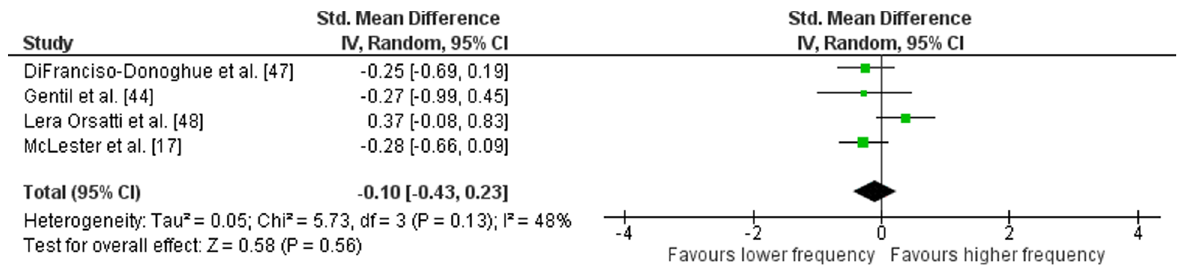
Fig. 14 Lower vs. higher weekly training frequency. Pre- vs. post-mean ES strength difference on isolation exercise. The vertical line indicates the overall estimate of combined multi-joint and isolation studies pre- vs. post-mean ES strength difference. Horizontal lines indicate 95% CI, squares estimates, whereas square size is proportional to sample size, and rhombs ’ meta-analytically pooled